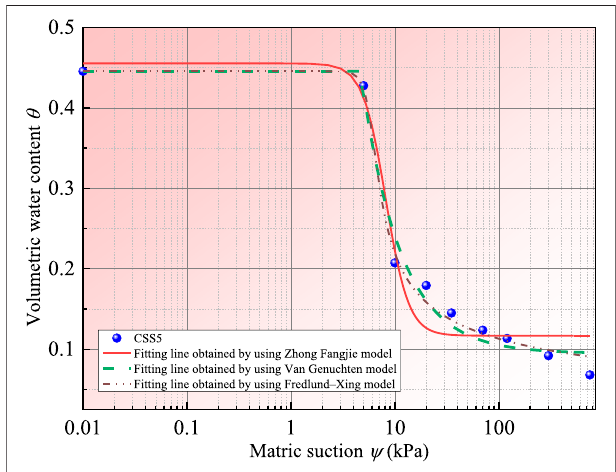
FIGURE 7 | Fitting results for SWCC of CSS5 by different models.